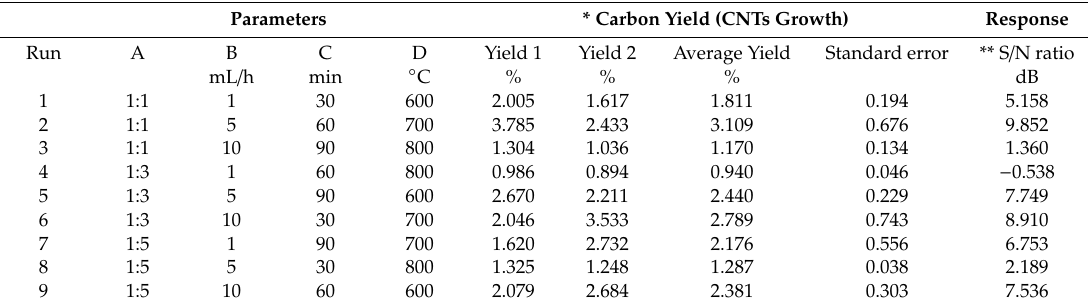
Table 1. Experimentally measured values for carbon nanotube (CNT) growth and standard error of CNT monolith and signal-to-noise (S / N) ratio (Taguchi orthogonal array table of L 9 (3 4 )). Parameters * Carbon Yield (CNTs Growth) Response